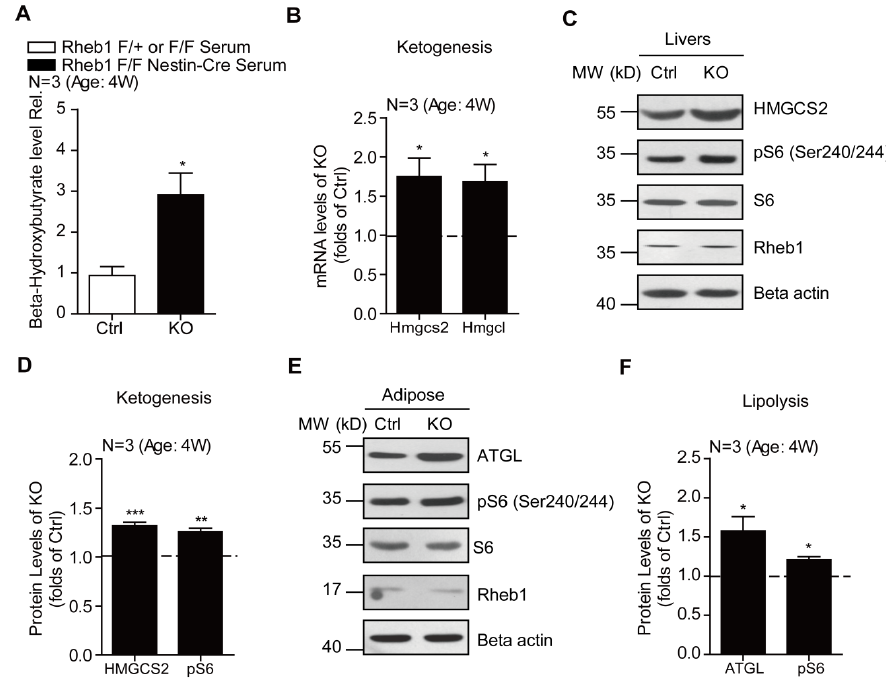
Figure 3. Genetic deletion of Rheb1 in the brain induces ketogenesis in the liver. ( A ) Biochemical assays showing increased blood ketone levels in 4-week-old Rheb1 ko mice ( N = 3). Results are averages of three independent animals. Data represent mean ± SEM. * p < 0.05; ( B ) Real-time PCR results showing the increasing levels of ketogenesis genes Hmgcs2 and Hmgcl in livers of Rheb1 ko mice ( N = 3). Results are averages of three independent animals. Data represent mean ± SEM. * p < 0.05; ( C , D ) Western blots and histograms showing the increasing of HMGCS2 protein level in livers of Rheb1 ko mice ( N = 3). Results are averages of three independent animals. Data represent mean ± SEM. ** p < 0.01, *** p < 0.001; ( E , F ) Western blots and histograms showing the increasing of ATGL protein level in adipose of Rheb1 ko mice ( N = 3). Results are averages of three independent animals. Data represent mean ± SEM. * p <